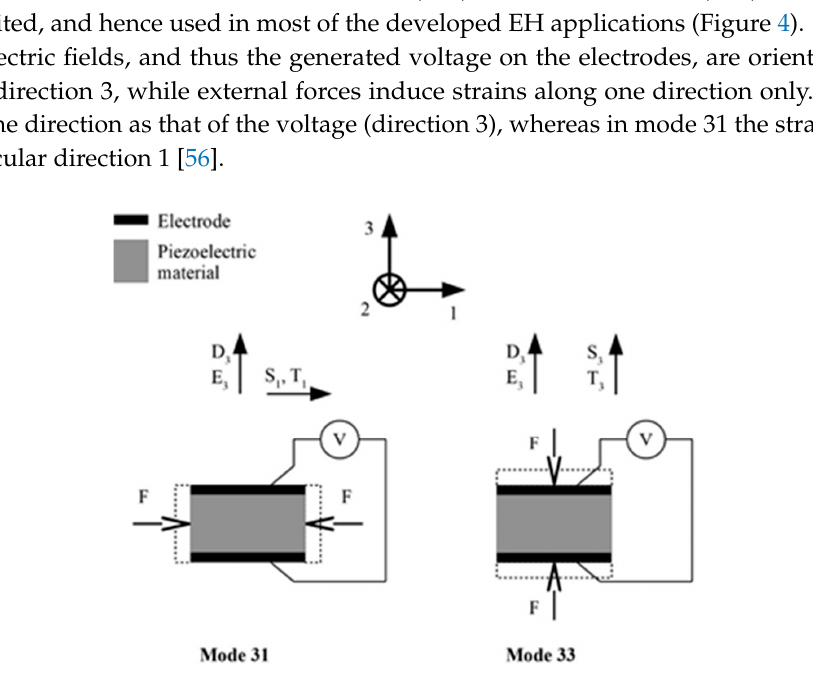
Figure 4. Operational modes of piezoelectric material for EH applications.